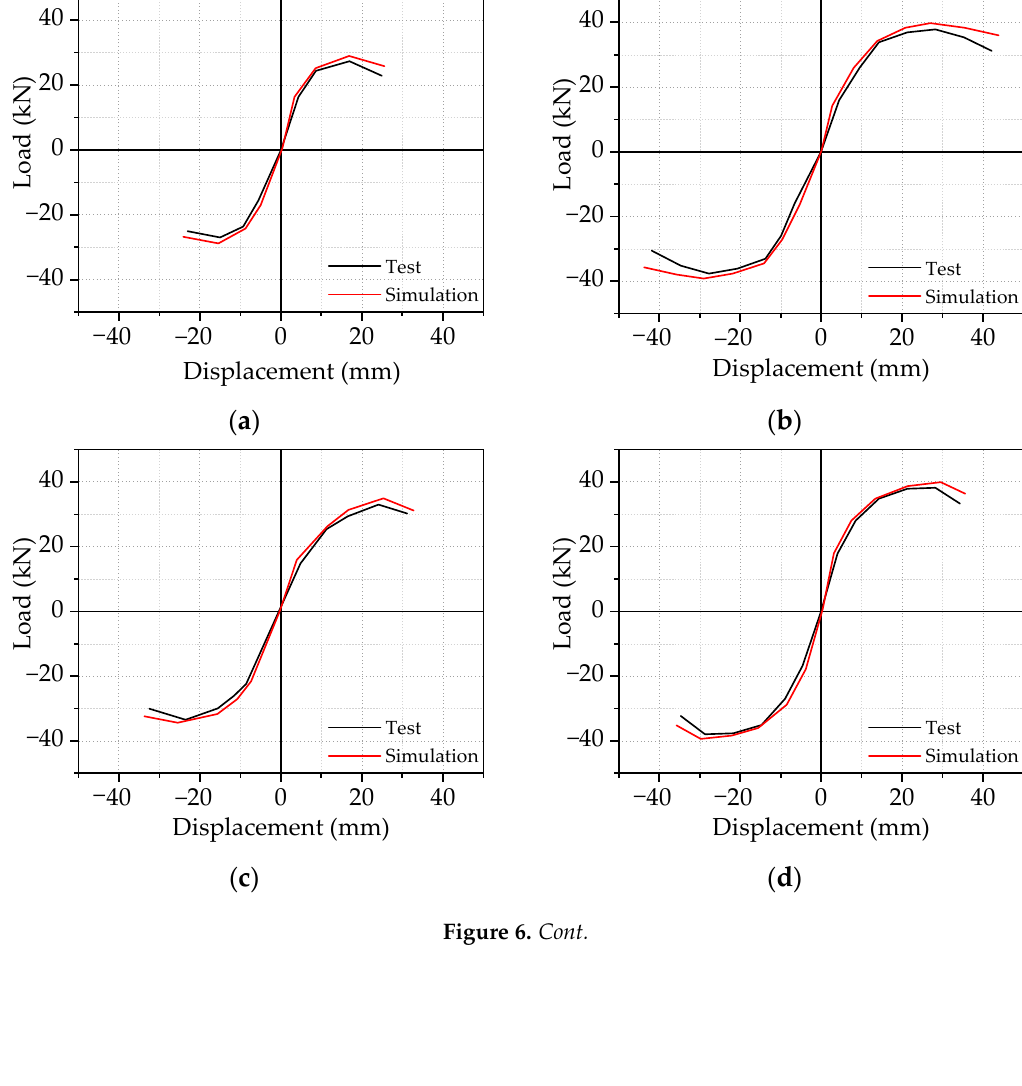
Figure 5. Comparison of hysteresis curves of ( a ) BCJ0; ( b ) BCJ1; ( c ) BCJ2; ( d ) BCJ3; ( e ) BCJ4; ( f ) BCJ5; ( g ) BCJ6.